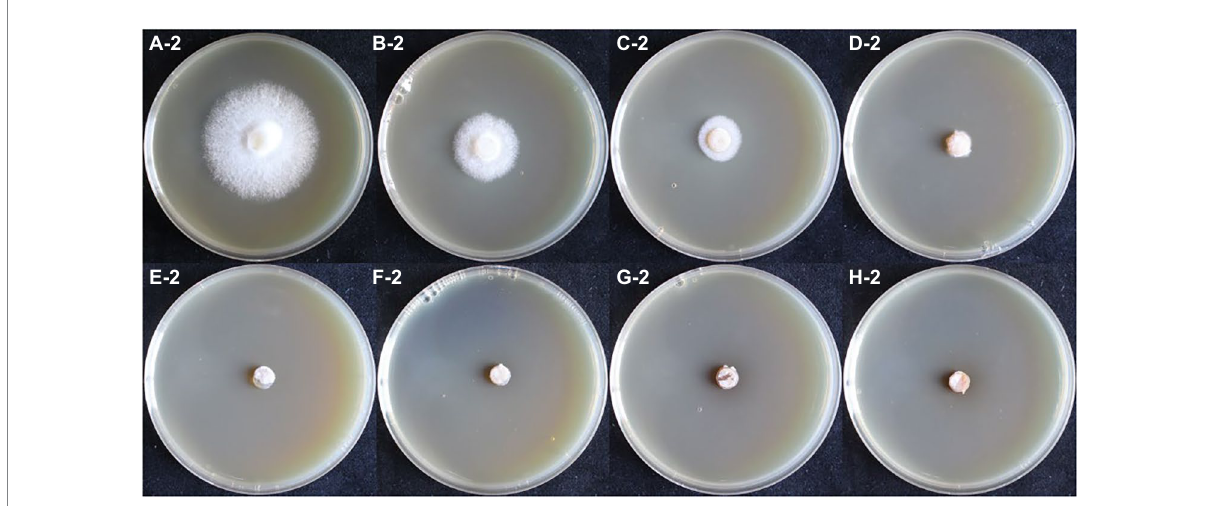
FIGURE 3 The growth of monokaryotic strain in different hygromycin concentrations. (A–H) The concentrations of hygromycin were 0, 6, 8, 10, 12, 14, 16, 18 μ g/ml,